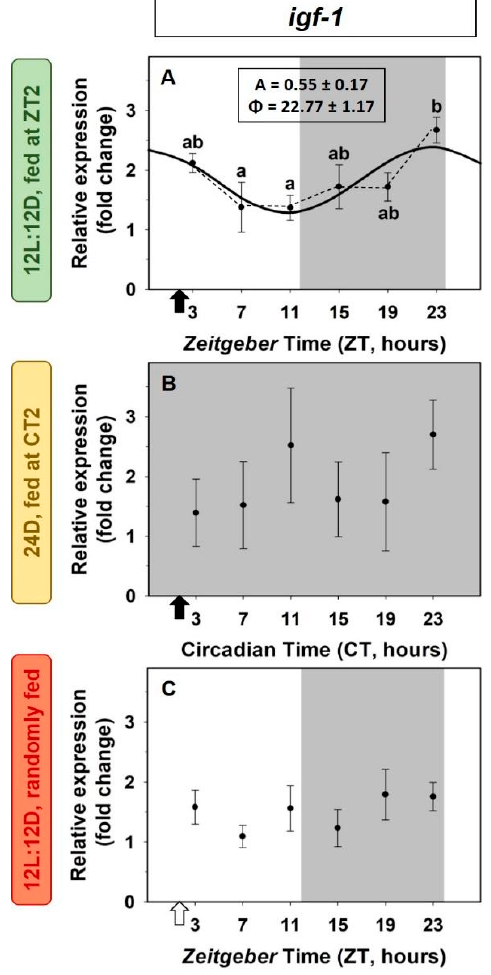
Figure 2. Daily variations of igf-1 expression in the liver of goldfish. ( A ) standard conditions group (12L:12D photoperiod, feeding time at ZT2); ( B ) 24D group (24 h darkness, feeding time at CT2); ( C ) random feeding group (12L:12D photoperiod, randomly fed). Data are expressed as mean ± s.e.m. ( n = 7/sampling time). Different letters indicate statistical differences among sampling times (ANOVA). Sinusoidal waves represent significant rhythm by cosinor analysis. Dashed lines represent significant differences among sampling points by ANOVA. Black arrows indicate feeding time. The white arrow indicates the time of the last feeding. The dark period is represented in grey. Parameters defining the rhythms (A: amplitude, ϕ : acrophase).